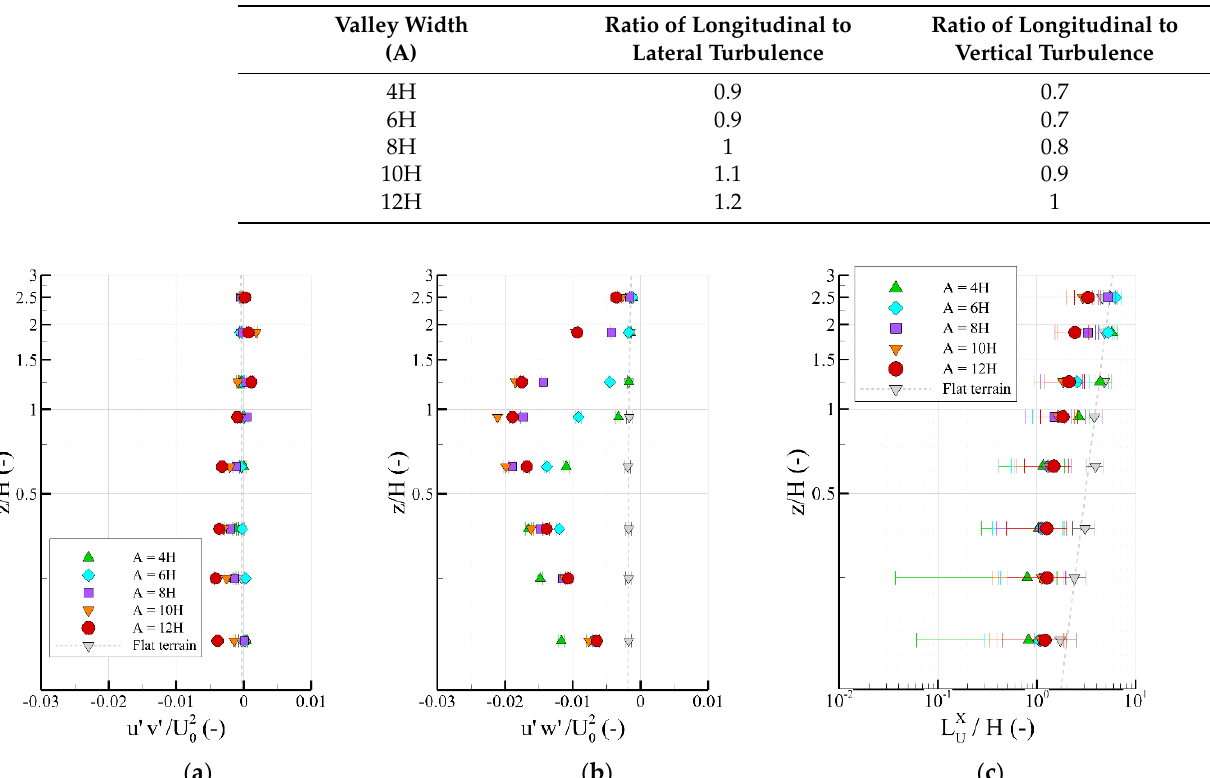
Figure 8. Semilogarithmic vertical profiles of the normalized horizontal ( a ) and vertical ( b ) turbulent fluxes above the crests of the second ridges; Logarithmic vertical profiles of the normalized longitudinal integral length scales above the crests of the second ridges ( c ).